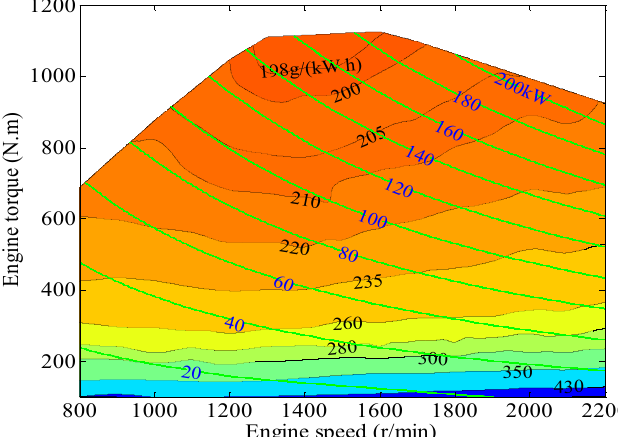
Figure 4. The distribution of BSFC and brake output power of the CNG engine.